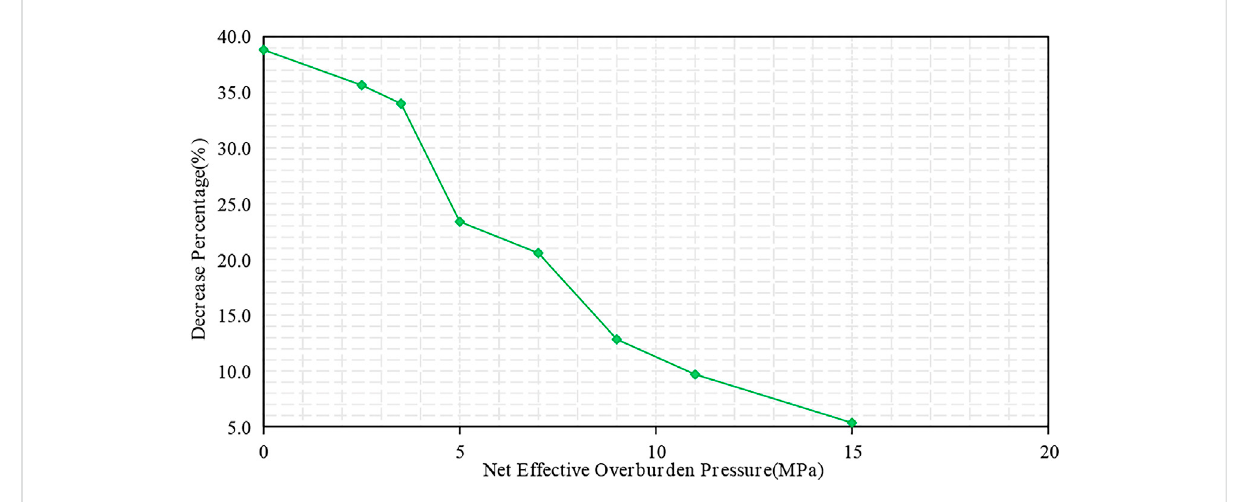
Decrease percentage of overburden permeability with decreasing